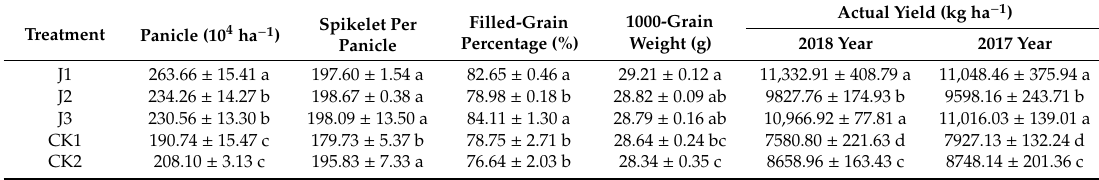
Table 4. Rice yield and yield components under the applied fertilization